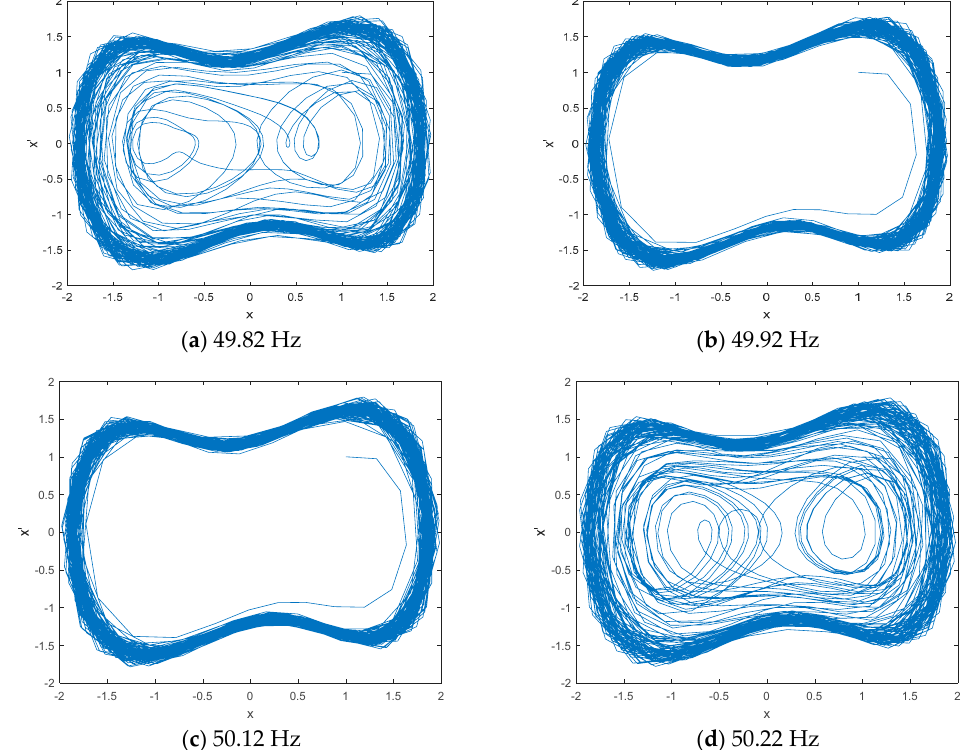
Figure 6. The phase space tracks of different driving force frequencies for IMF8.